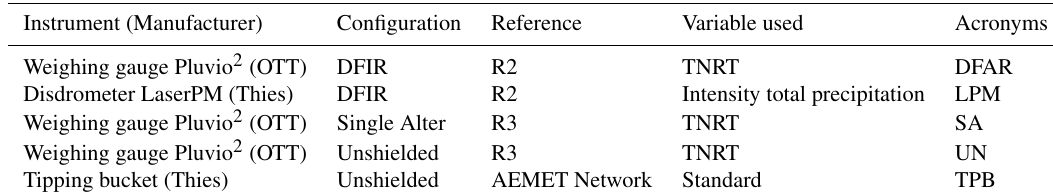
Table 1. List of instruments being tested at the Formigal–Sarrios WMO-SPICE site. Instrument (Manufacturer)